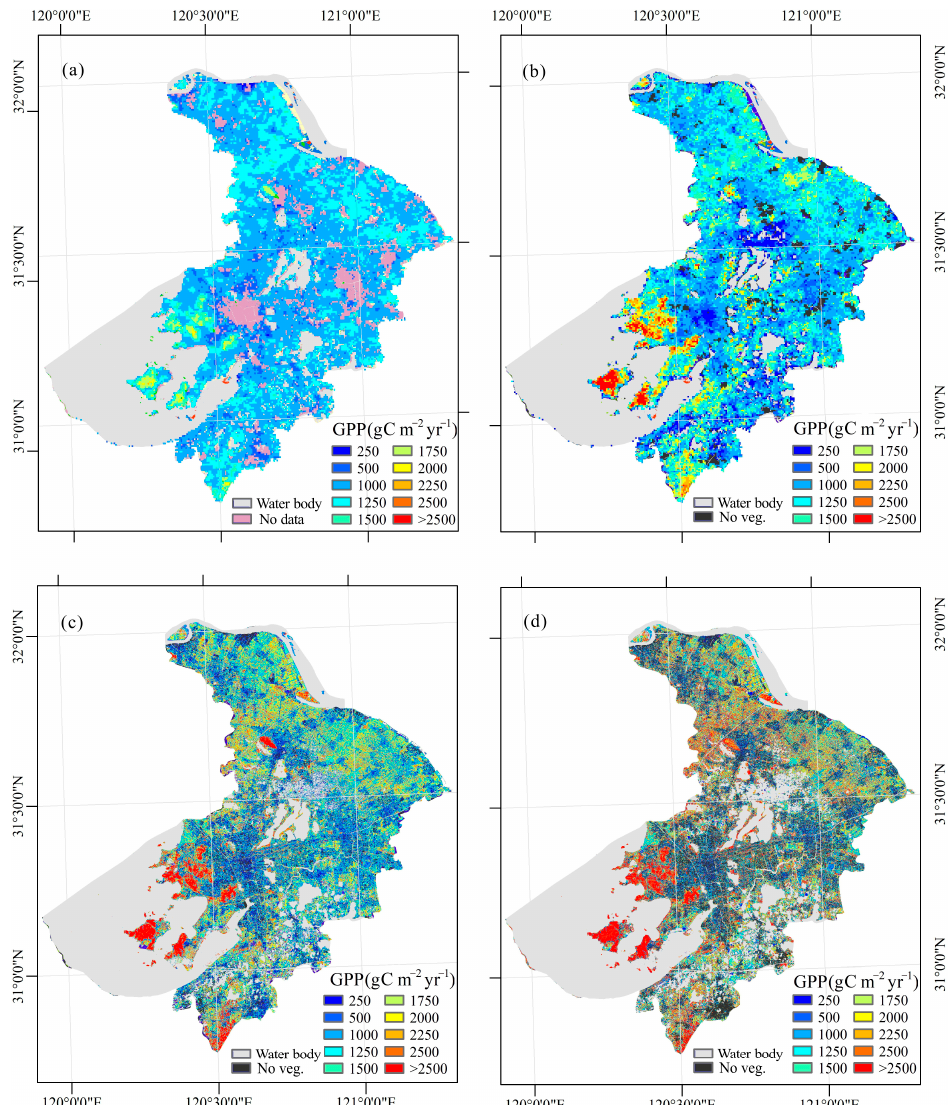
Figure 4. The spatial distribution of GPP from MOD17A2 product ( a ) and estimated by MODIS ( b ), Landsat-8 ( c ), Sentinel-2 ( d ). Areas in panel ( a ) with no data are due to the MODIS product not calculating GPP if the land cover type is built area. Additionally, the no vegetation (veg.) areas in panels ( b – d ) are the regions where the NDVI is less than 0.2 and, as a result, is recognized as bare land with no GPP.